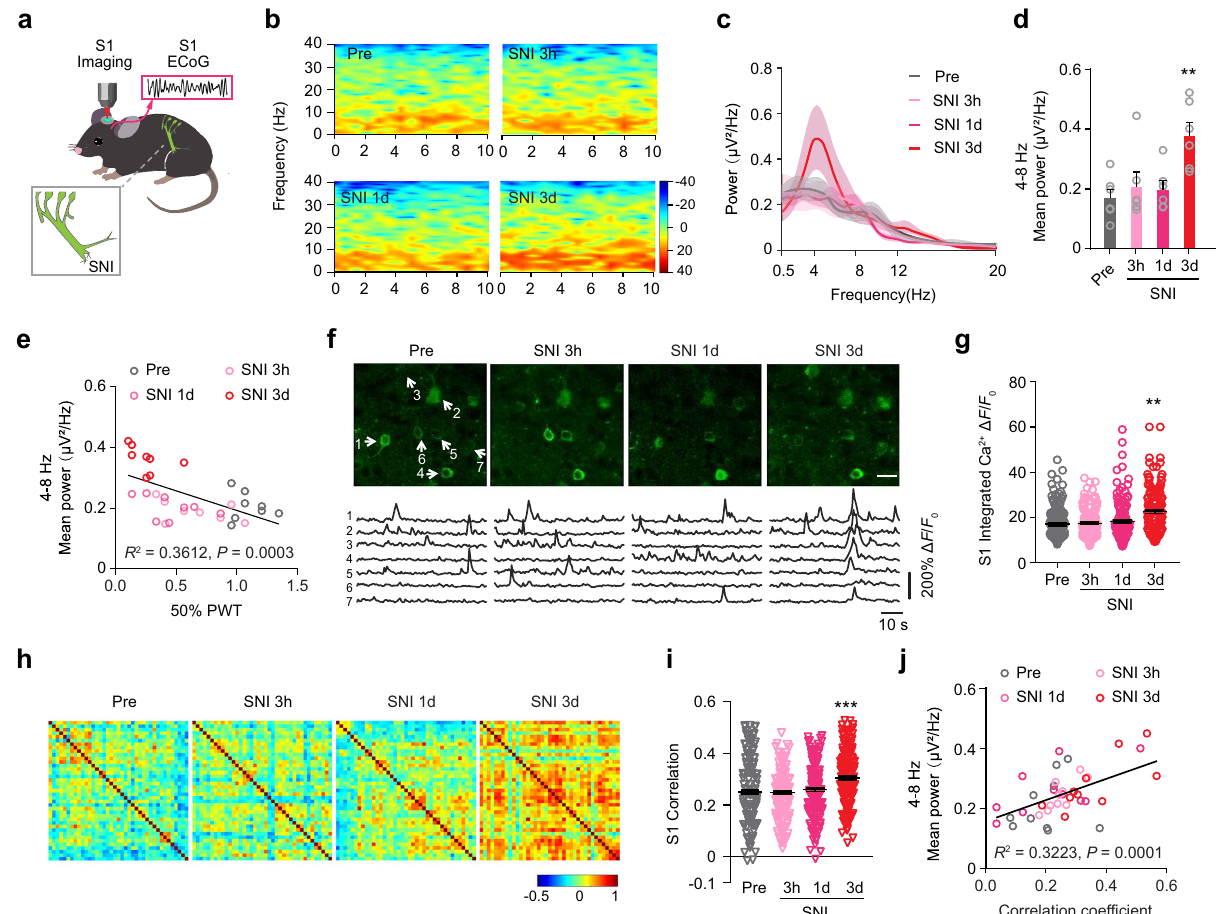
Fig. 1 | Peripheral nerve injury induces activity synchrony in S1. a Schematic showing ECoG recording and Ca 2+ imaging of L2/3 pyramidal neurons in S1 HL region in awake behaving SNI mice. Pink inset: ECoG recording; gray inset: SNI surgery. b SpectrogramsofECoG signalsinS1of awakebehaving SNImice. c ECoG powerspectrabefore(Pre),3hours, 1 day, and 3 days afterSNI. d The mean power in theta band (4 – 8Hz). e ECoG power in theta band correlates inversely with mechanical paw withdraw threshold. f Representative two-photon images and fl uorescence traces of L2/3 pyramidal neurons in S1 before and after SNI. Arrows